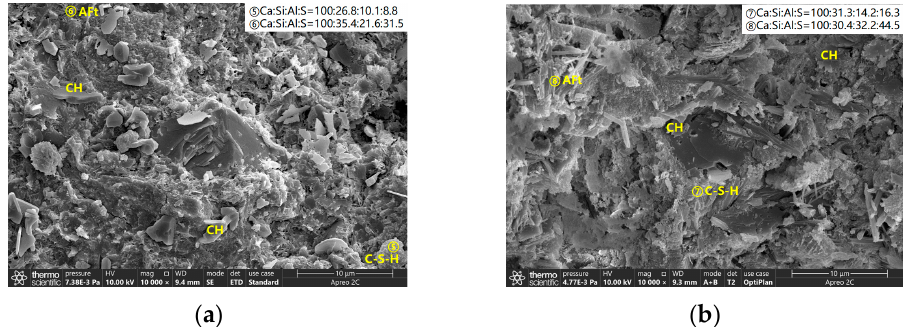
Figure 10. The microstructure of cement samples at 60 d: ( a ) PA0-045-60d; ( b ) PA9-045-60d. After leaching, a large number of pores appeared on the surface of the samples in Figure 11. Calcium hydroxide and ettringite disappeared, which were in general agreement with the XRD test results. The C-S-H gel was partially dissolved [50–52], presenting a loose porous microstructure and a decrease in Ca/Si due to Ca-leaching [6,22], as shown in Figure 11. Compared to the sound samples, the leached present a loose porous microstructure, resulting in a reduction in strength [53].